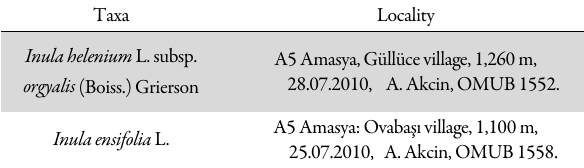
Table 2. Anatomical measurements of examined Inula L. taxa. (data are given as mean ± sd, P < 0.05 denote a statistically difference between two species)